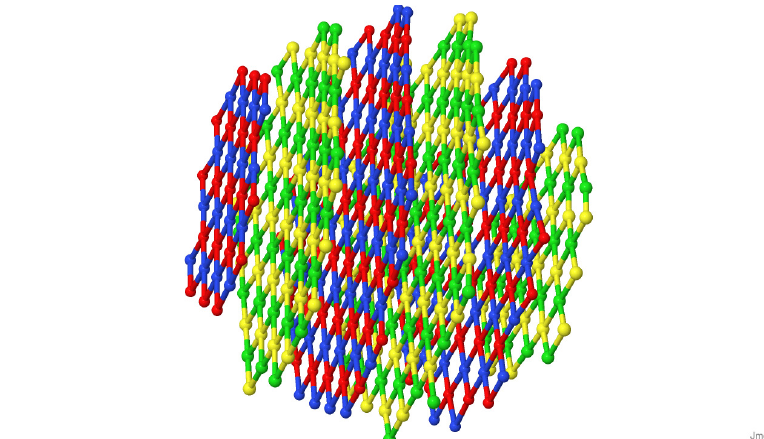
Figure 2: A sample of a simulation result for the oriented two-body interaction of 5d instanton dynamics (i.e. with α = β = 1). The lattice is tetragonal with non- Abelian orientation structure. The colors show the four different orientations of the instantons. The figure was created by using the Jmol software [ 45 ] . An interactive 3D version of the figure can be viewed with Adobe